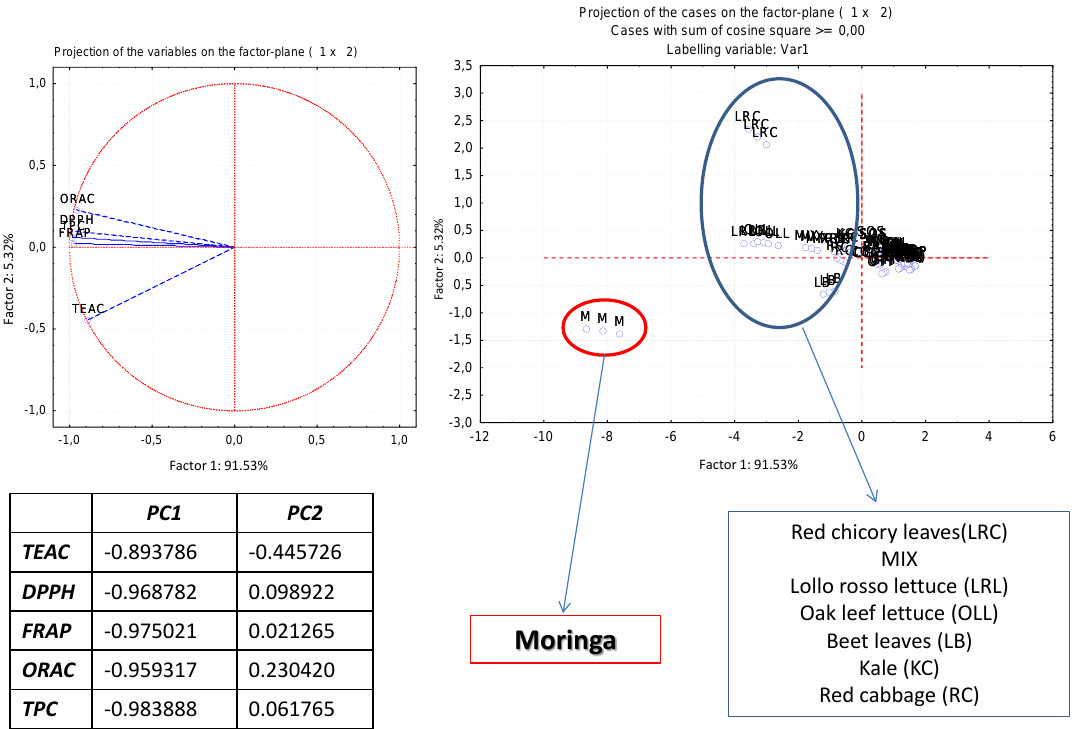
Figure 1. Loadings ( left ) and Scores ( right ) for plots obtained by principal component analysis of methanol extract from the vegetable